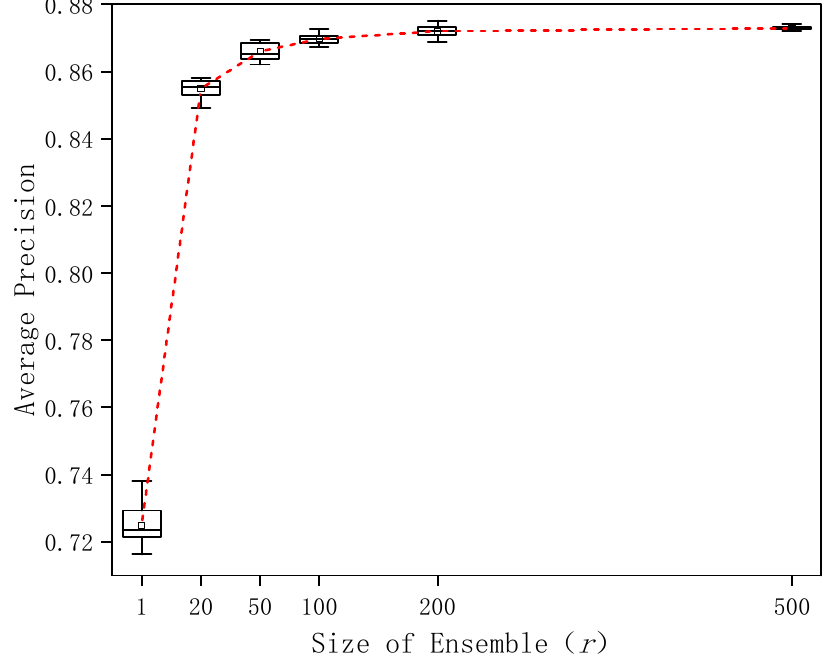
Figure 4. Average accuracy and variance of RSFCF over Small60 datasets under different ensemble sizes.